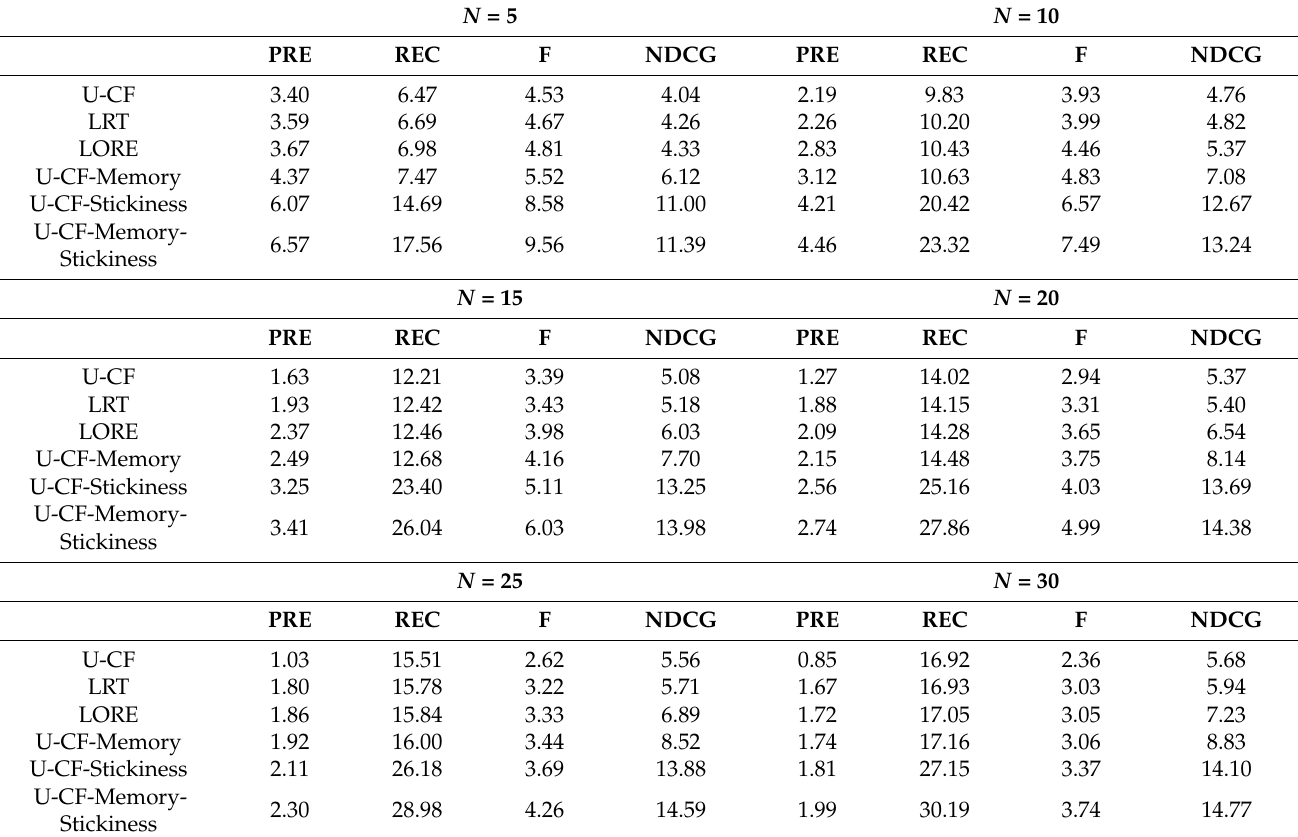
Table 2. Comparison of recommendation